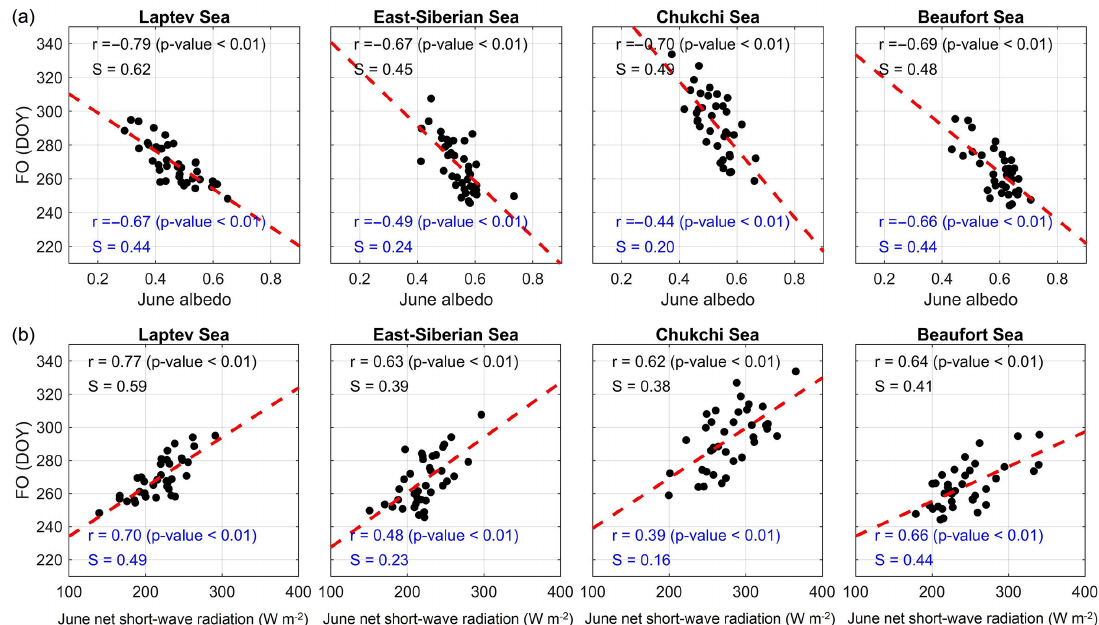
Figure 8. Scatterplots showing the relationships between autumn FO and ( a ) June albedo and ( b ) June net short-wave radiation in the Laptev, East-Siberian, Chukchi, and Beaufort Seas. Black and blue texts represent the statistics based on undetrended and detrended time series,